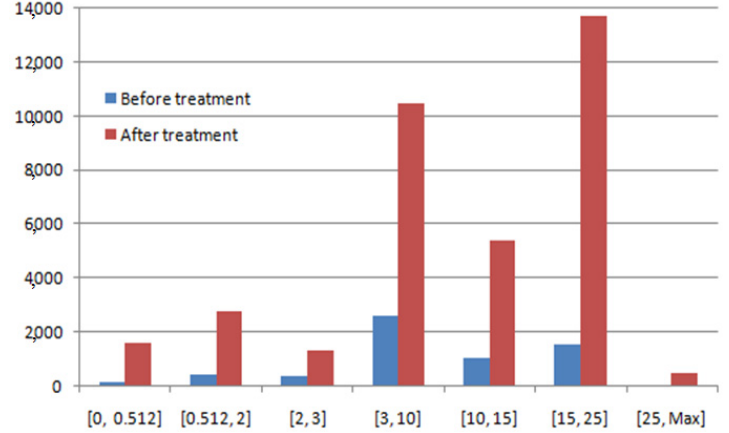
Figure 16. Histogram’s distribution of PUSCH (before and after treatment).